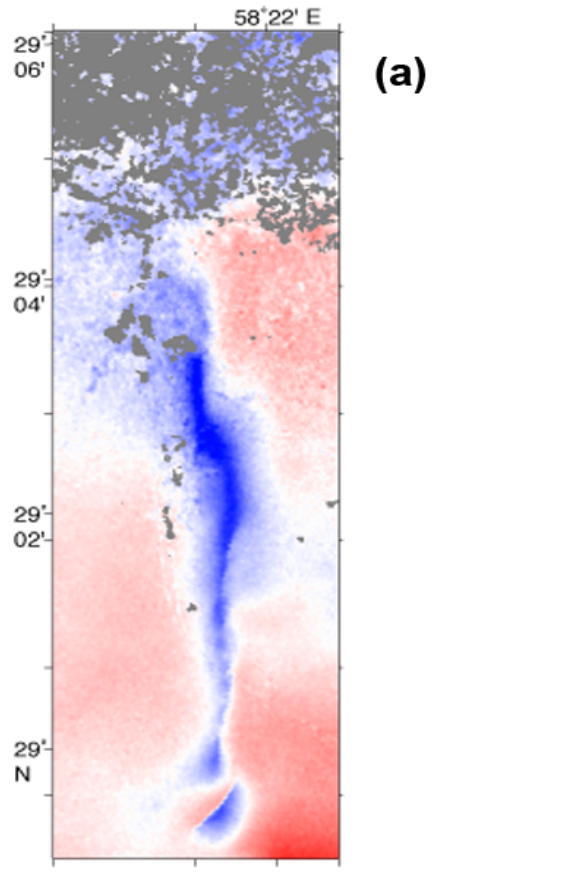
Figure 9. Post-seismic deformations for the Bam earthquake (M = 6.6, 26 December 2003, Iran). (a) Vertical displacement of the land surface south of Bam, during the three and a half years after the earthquake derived from analysis of radar images. The dark blue area sank a total of more than 3 cm (1.2 inches), revealing a zone of rock that was damaged during the earthquake and then healed afterwards. (b) False-color Landsat Thematic Mapper image taken on October 1, 1999 of the area of the earthquake rupture south of Bam. Red line shows location of the fault damage zone above the buried 2003 rupture. Vegetation in the city of Bam is green and stone-covered desert has various tones of gray